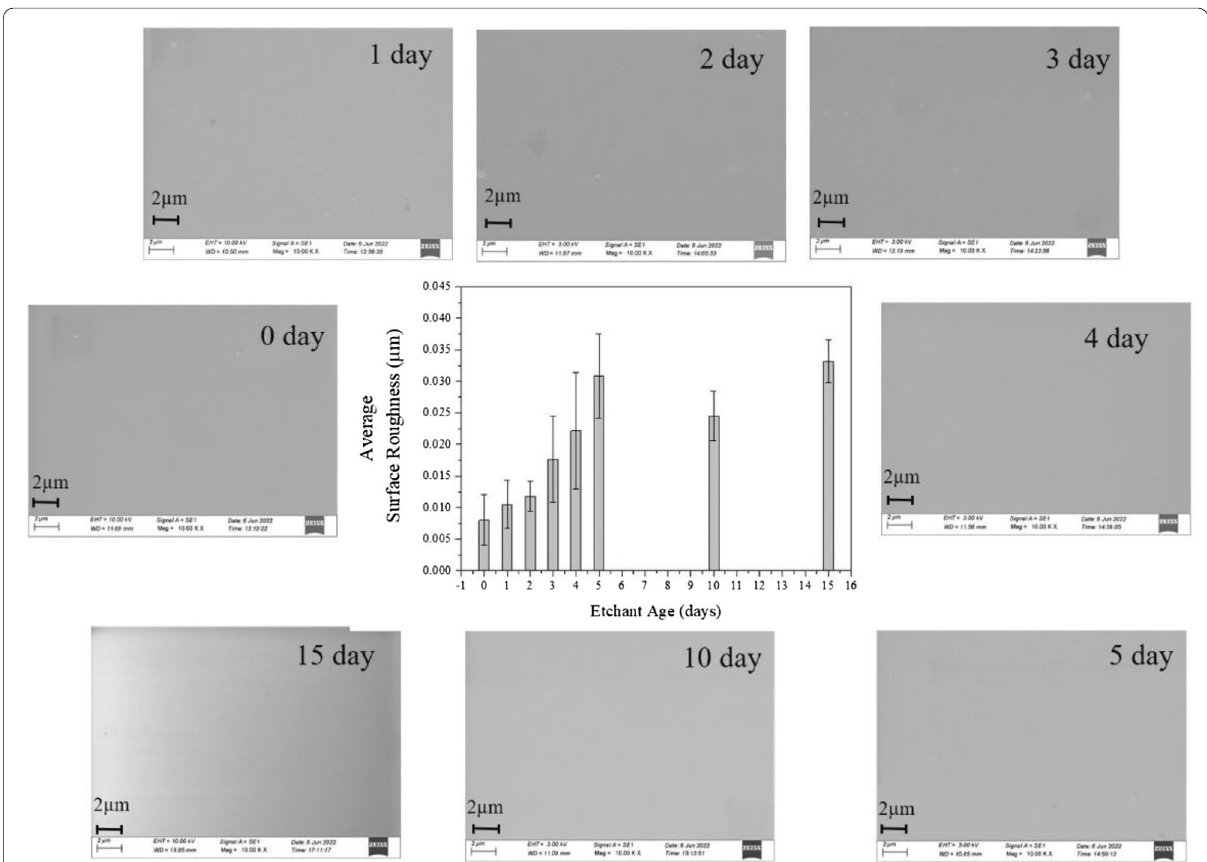
Fig. 7 Effect of etchant age (12%NH 2 OH